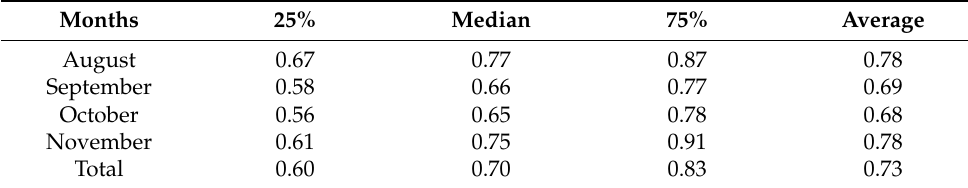
Table 2. Astronomical seeing statistics for each month for Maidanak Observatory.